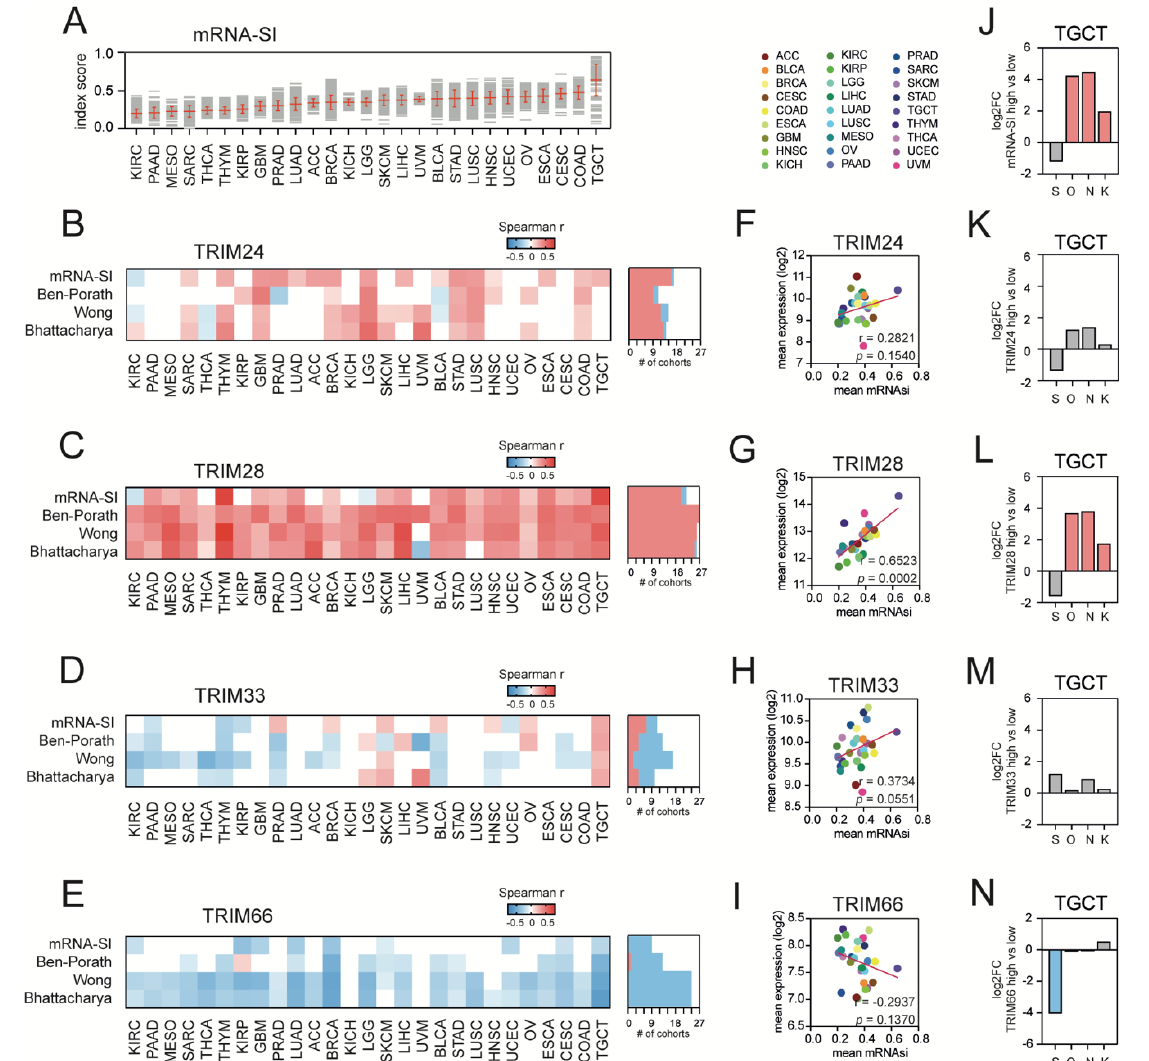
Figure 2. The association of the expression of TIF1 family members with cancer stemness. ( A ) The transcriptome-based stemness index (mRNA-SI) calculated for 27 TCGA solid tumor types. ( B – E ) The heatmap of Spearman’s correlation between ( B ) TRIM24, ( C ) TRIM28, ( D ) TRIM33, and ( E ) TRIM66 expression and distinct stemness scores (mRNA-Stemness Index, Ben-Porath ES core signature, Wong ESC core signature, Bhattacharya ESC signature). Note the strong positive association between TRIM28 expression and stemness indices and the negative association between TRIM66 expression and stemness indices across distinct tumor types. The number of TCGA cohorts characterized with either a positive (red) or negative (blue) correlation between the expression of specific TIF1 family members and tested stemness scores/signatures are shown. ( F – I ) The Spearman’s correlation between the mean TRIM24 ( F ), TRIM28 ( G ), TRIM33 ( H ), or TRIM66 ( I ) expression level and the average mRNA-SI score across 27 solid tumor types. ( J ) mRNA-SI HIGH TGCT tumors express significantly higher levels of stemness transcription factors Octamer-binding transcription factor 4 (OCT-3/4), Nanog Homeobox (Nanog), and Kruppel Like Factor 4 (KLF4). ( K – N ) Among other TIF1 members, only TRIM28 HIGH TGCT tumors express significantly higher levels of OCT-3/4, Nanog, and KLF4. S–SOX2 (SRY (sex determining region Y)-box 2), O–OCT-3/4, N–NANOG, and K–KLF4. Red—significant upregulation; blue—significant downregulation; grey—no statistical significance (FDR >